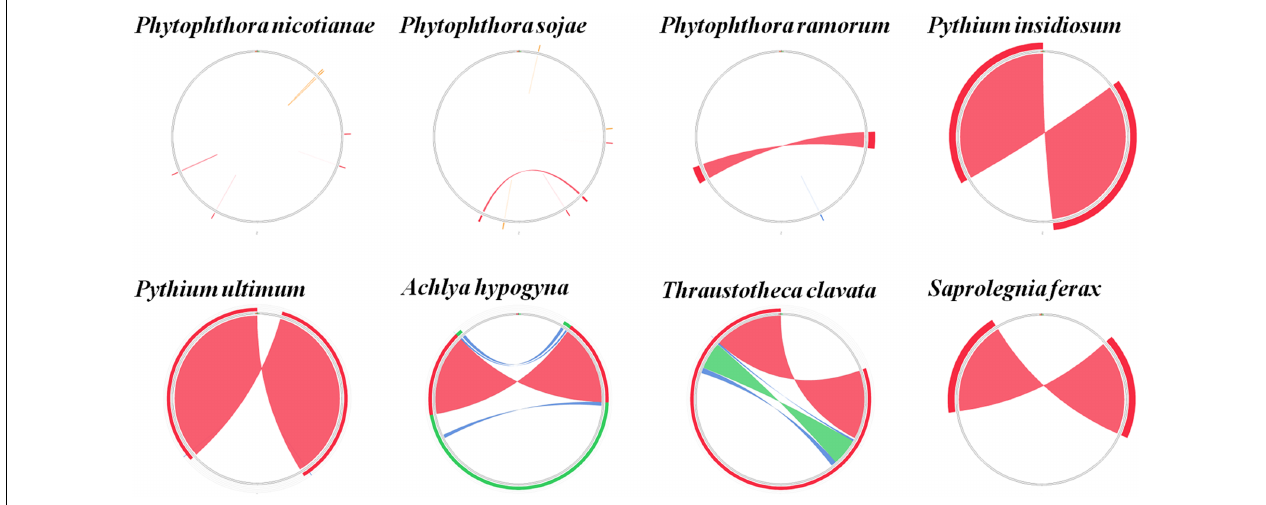
FIGURE 5 | Comparison of inverted repeat regions in oomycetes species. There were no repeat regions in P. nicotianae and P. sojae . Repeat regions of 1.1 kb repeat regions were found in P. amorum . Reverted repeat regions of 18.3, 22, 7.7, 9.4, and 8.6 kb reverted repeat regions were found in P. insidiosum , P. ultimum ,